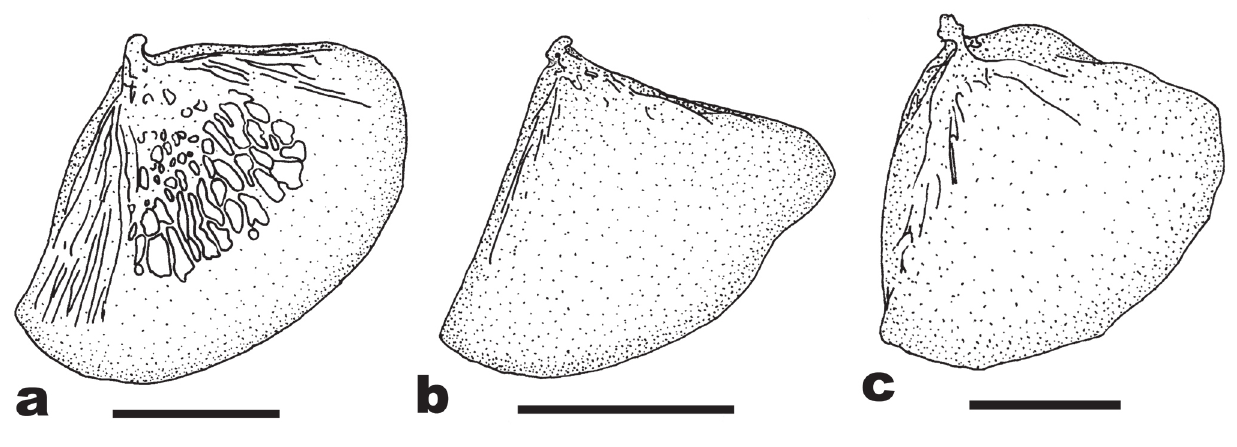
Fig. 11. Opercle shape. ( a ) Rhamphichthys drepanium , UF 78066; ( b ) Gymnorhamphichthys rosamariae , MCP 24359; and ( c ) Hypopomus artedi , ANSP 177489. Lateral view of left side. Anterior to left. Scale bar is 5